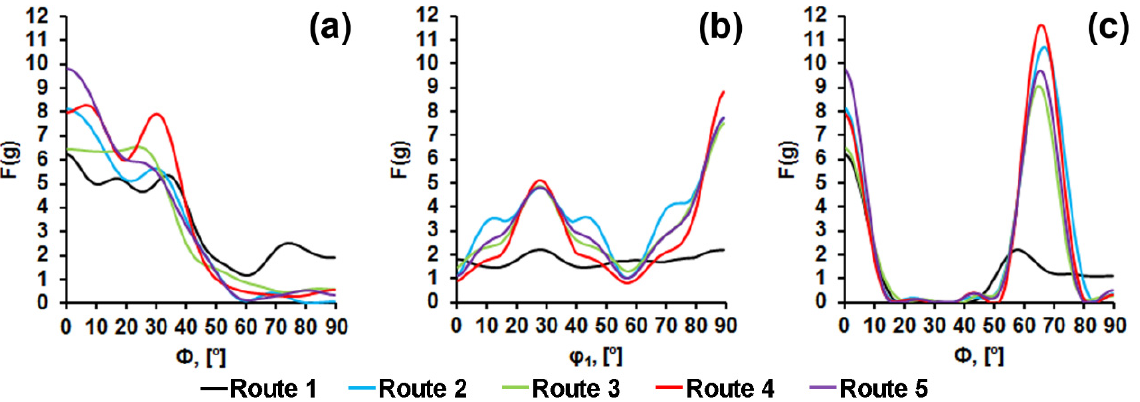
Figure 10. Normalized pole density distribution along Euler angles: ( a ) φ 2 = 45°, Φ = 0–90°, φ 1 = 0°; ( b ) φ 2 = 45°, Φ = 55°, φ 1 = 0–90°; ( c ) φ 2 = 45°, Φ = 0–90°, φ 1 = 90°.